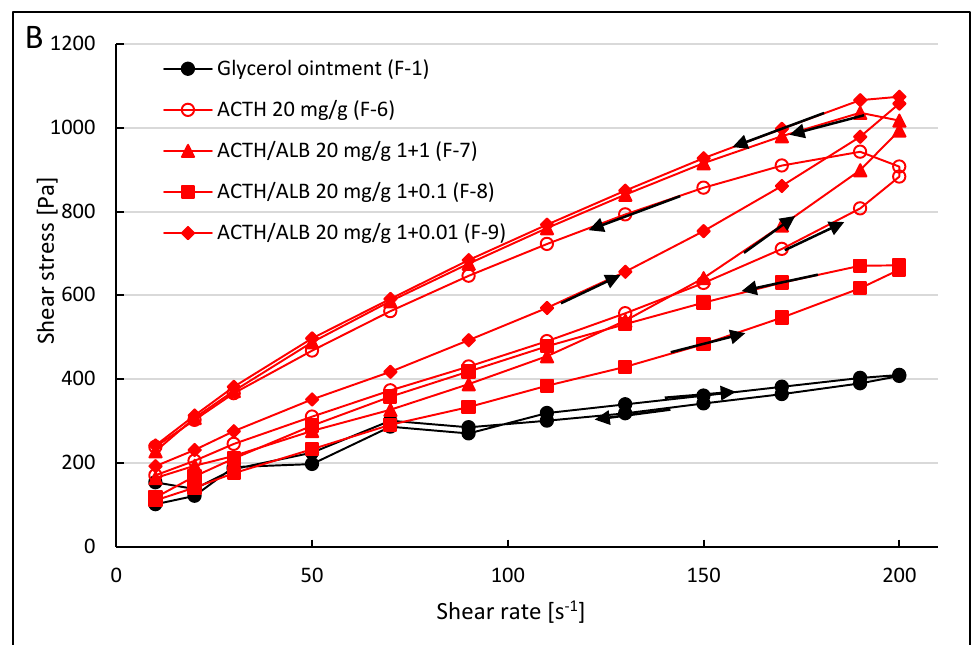
Figure 6. Hysteresis loops for preparations containing 15 mg/g ACTH (F-2) and 15 mg/g ACTH and albumin: 1:1; 1:0.1; 1: 0.01 (F-3–F-5) ( A ) and for formulations containing 20 mg/g ACTH (F-6) and 20 mg/g ACTH and albumin: 1:1; 1:0.1; 1: 0.01 (F-7–F-9) ( B ) compared to glycerol hydrogel-F-1, n = 5.4.